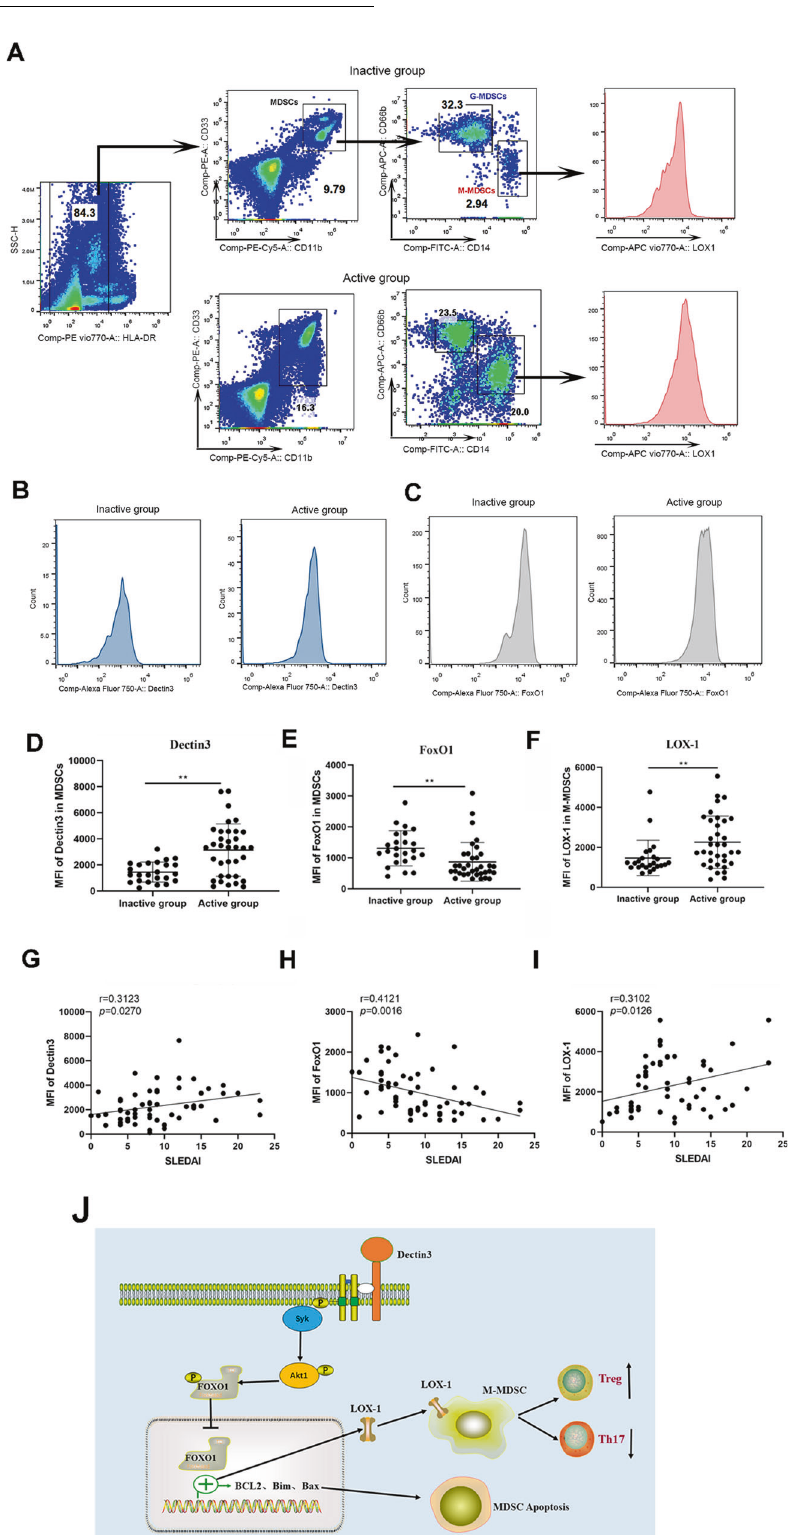
Fig. 8 Dectin3 expression positively correlated with the level of LOX-1 on M-MDSCs in patients with SLE. A Schematic diagram of fl ow cytometric detection of peripheral blood MDSCs and M-MDSCs in patients with SLE, and LOX-1 expression detection diagram in M-MDSCs (10 samples in the inactive stage of the disease and 10 samples in the active stage of the disease). B , C Flow cytometry analysis of Dectin3 (up) and FoxO1 (down) expression in peripheral blood MDSCs. D – F Statistical data of the expression of Dectin3, FoxO1, and LOX-1 in peripheral blood MDSCs. G – I The correlations of Dectin3, FoxO1, and LOX-1 expressions with the score of SLEDAI. J Schematic diagram of the regulation of the accumulation in Dectin3-de fi cient mice with lupus. Data represent the mean scores ± SEM. * P ≤ 0.05, ** P ≤ 0.01, and *** P ≤ 0.001; active group: n = 35, inactive group: n =